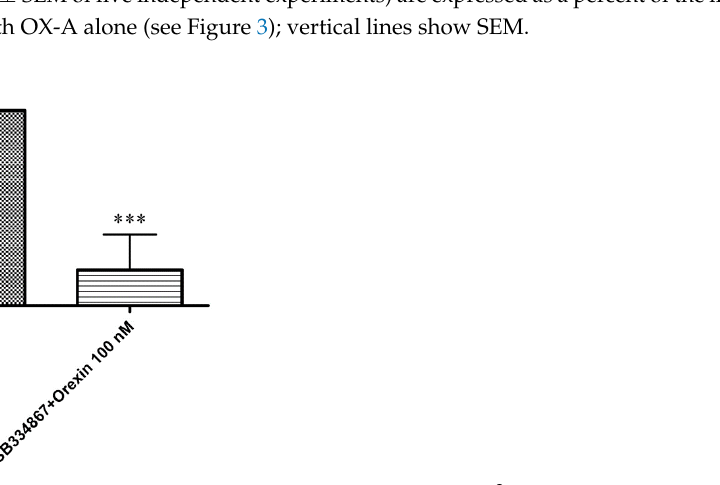
Figure 3. Effect of the OX1R antagonist SB334867 (10 μ M) on the Ca 2+ elevation induced by OX-A (100 nM) in CHO cells overexpressing OX1R. Data are expressed as means ± SEM, ( n = 4). *** p <